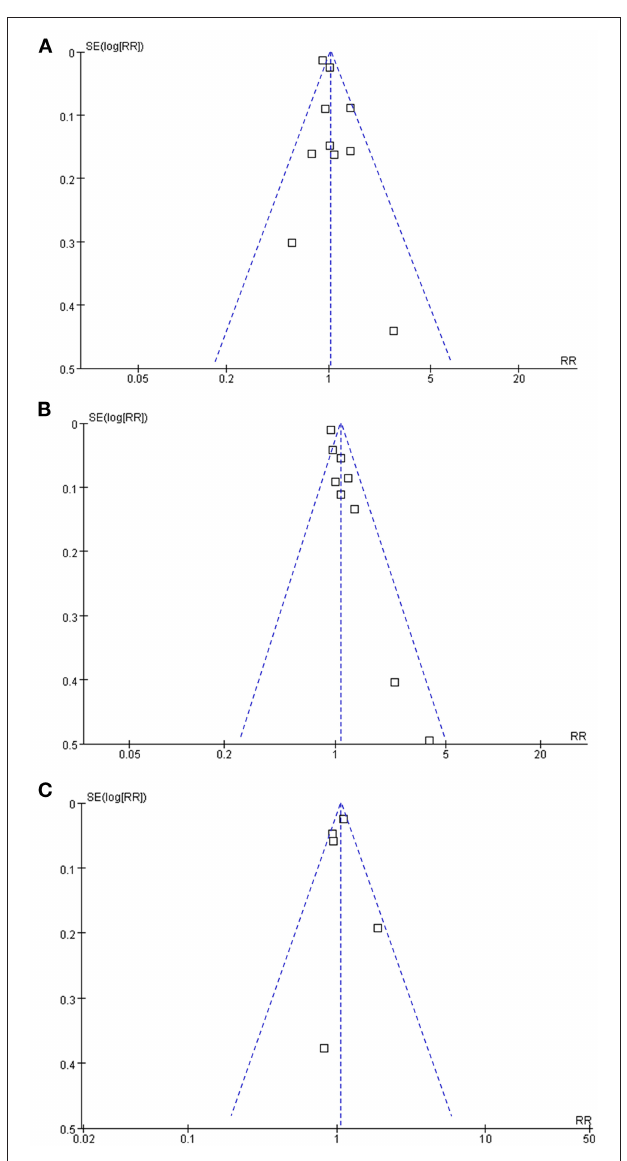
FIGURE 5 | Funnel plots for the publication bias underlying the meta-analyses; (A) funnel plots for the meta-analysis of the association between glaucoma and the incidence of AD; (B) funnel plots for the meta-analysis of the association between glaucoma and the incidence of all-cause dementia; and (C) funnel plots for the meta-analysis of the association between glaucoma and the incidence of non-AD dementia.